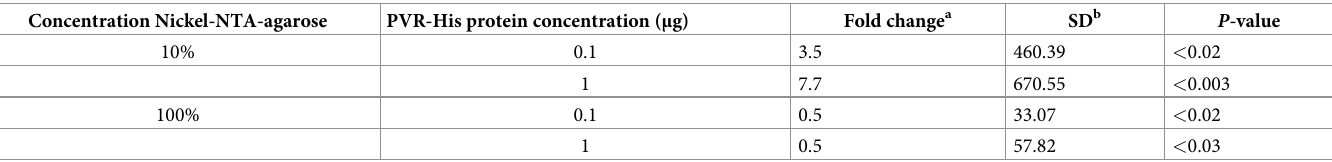
Table 2. Development of the PVR-His protein capture assay using different concentrations of nickel agarose and PVR-His protein. Fold change of mean RNA copy numbers with PVR-His capture (enrichment step) were compared to extracted RNA without PVR-His. P -values were calculated by t -test. Quantitative RT-PCR was per- formed using 1 μ L template